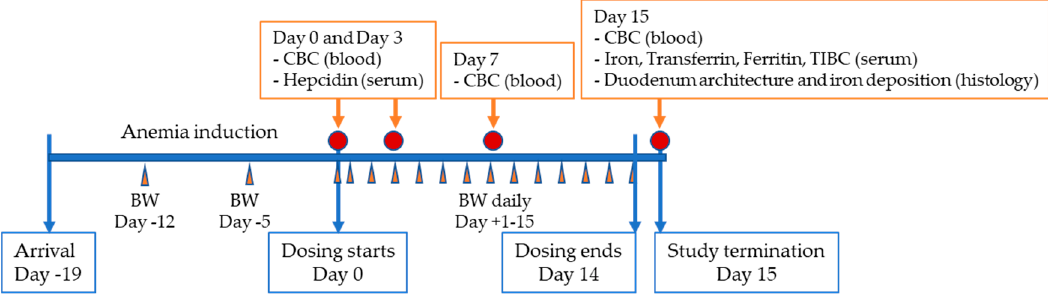
Figure 1. Study timeline. CBC: Complete blood count included measurement of hemoglobin, mean corpuscular volume, hematocrit and hemogram; BW: Body weight; TIBC: Total iron binding capacity.